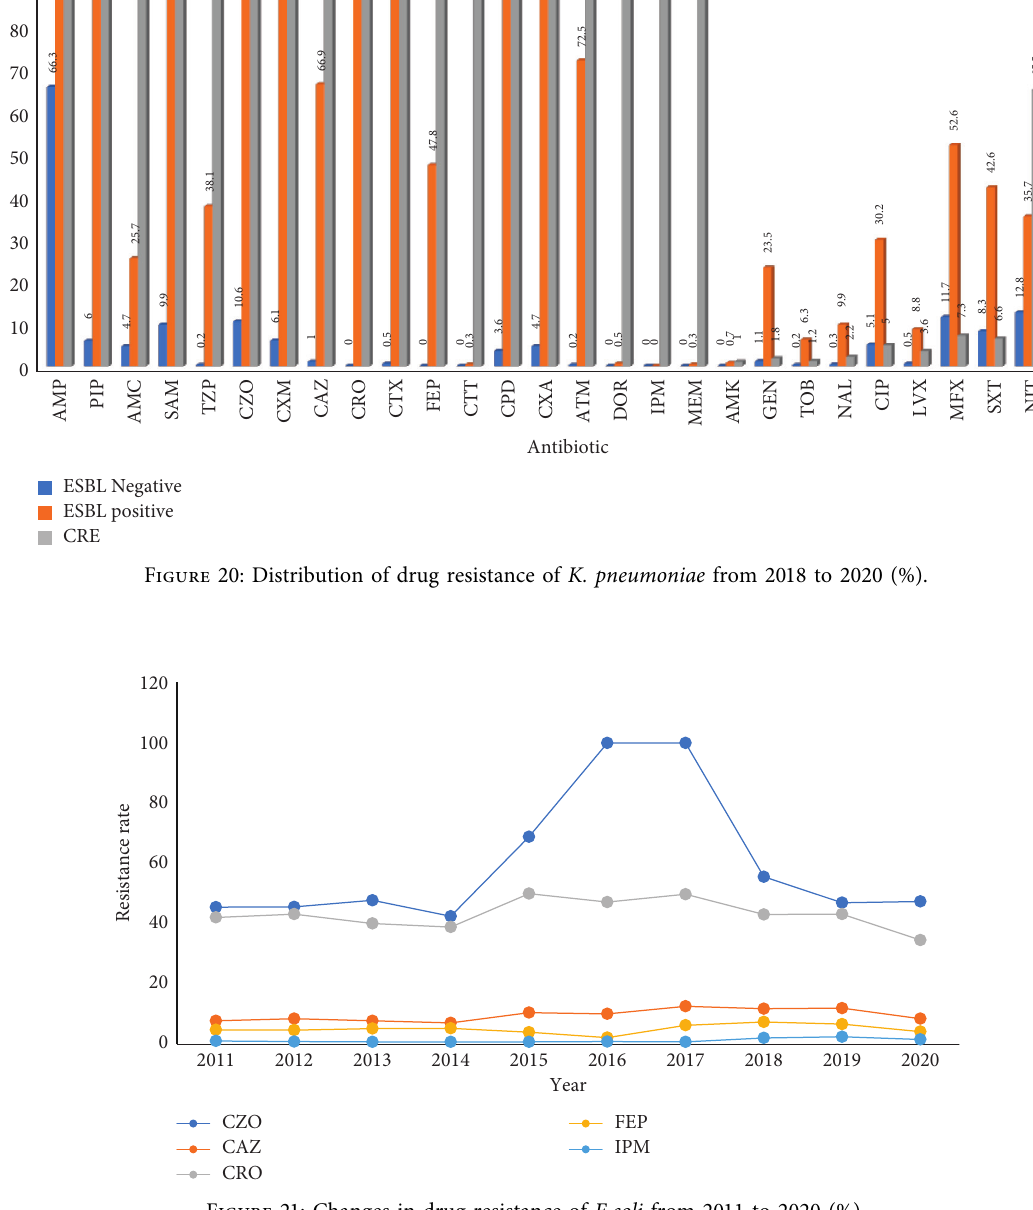
Figure 21: Changes in drug resistance of E.coli from 2011 to 2020